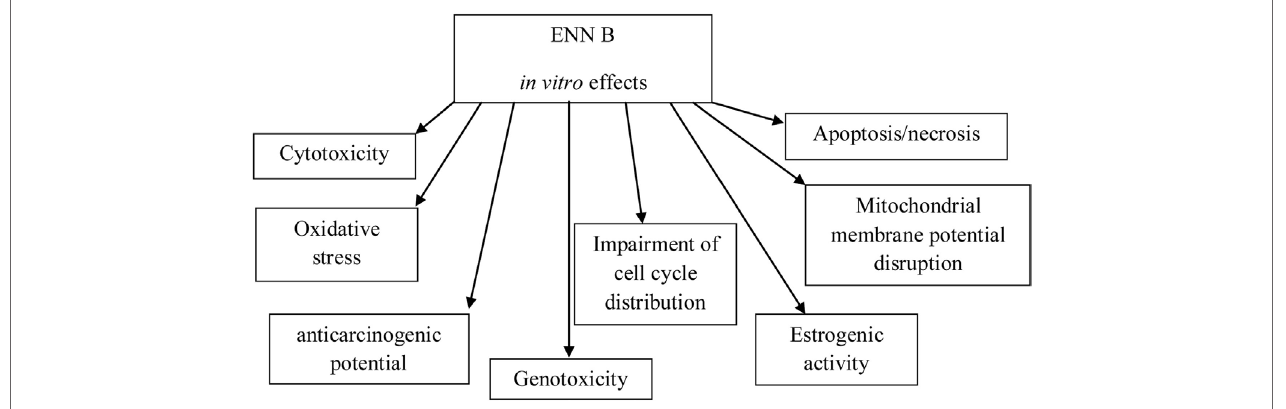
FiGURe 3 | Schema showing in vitro effects of enniatin B (ENN